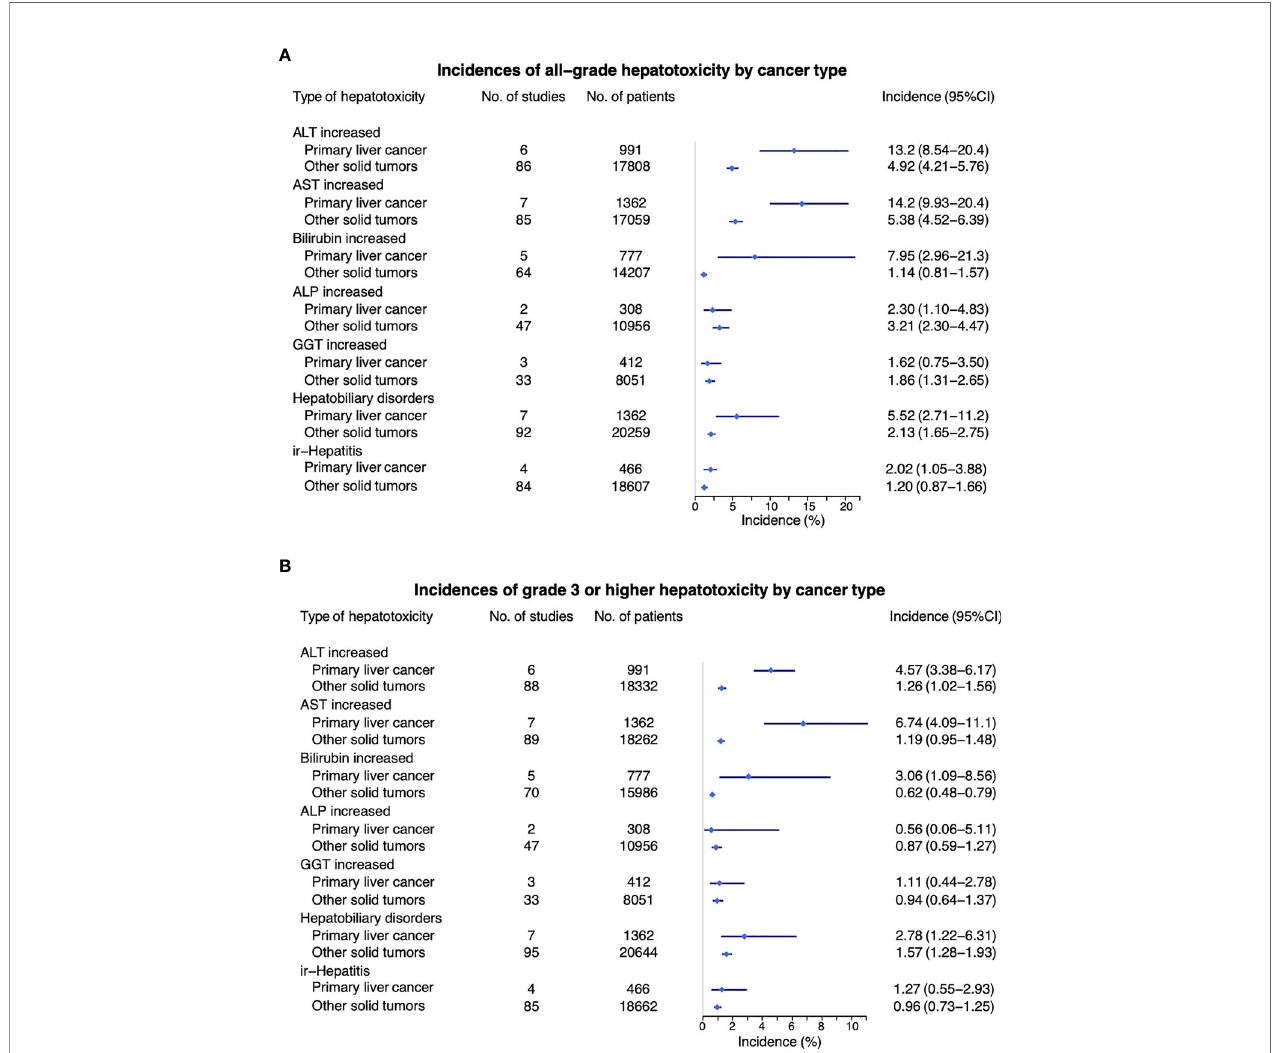
FIGURE 3 | Comparison of incidence of all-grade (A) and high grade (B) hepatotoxicity between primary liver cancer vs other tumor